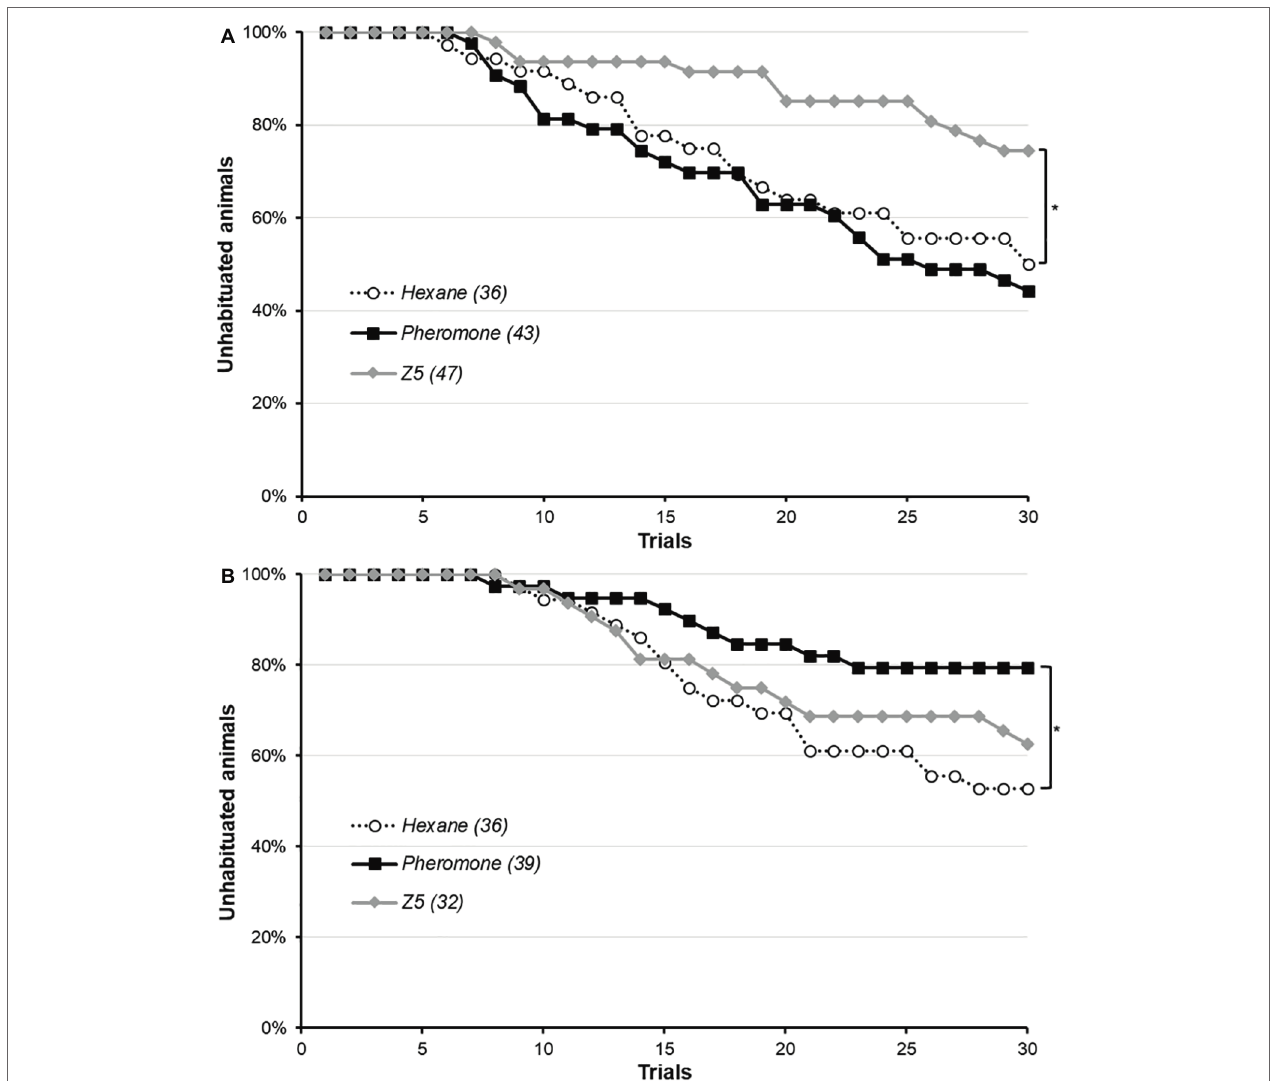
FIGURE 2 | Effect of conspecific sex-pheromone and Z5 on gustatory habituation in male Agrotis ipsilon . The x-axis shows the trials in the habituation protocol, and the y-axis the proportion of unhabituated moths, which starts at 100% and then decrease as more and more moths reach the habituation criterion. Each curve corresponds to a treatment (i.e., pre-exposure to hexane, conspecific sex-pheromone or Z5), and values in parenthesis are the sample sizes. In part A , the pre- exposure was done immediately before the habituation protocol and in part B , it was done 24 h before the habituation protocol. Significant difference with the control hexane group are denoted by a star (*: Cox regression, p <